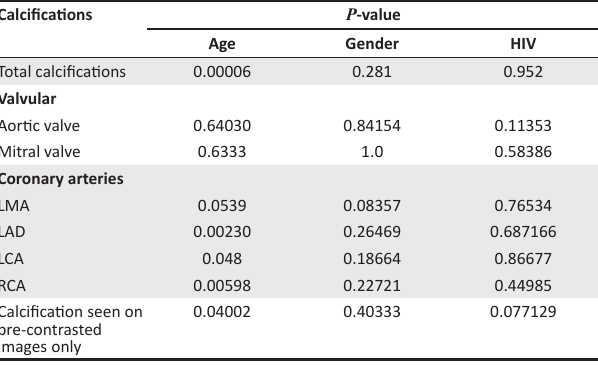
TABLE 1: Estimated probability of calcification as a function of age, gender and HIV status.